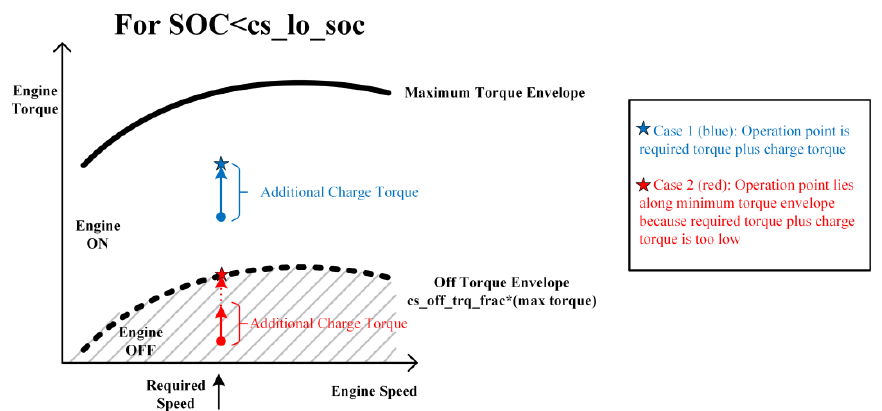
Figure A2. EMS operation when SOC is lower than “cs_lo_soc”.